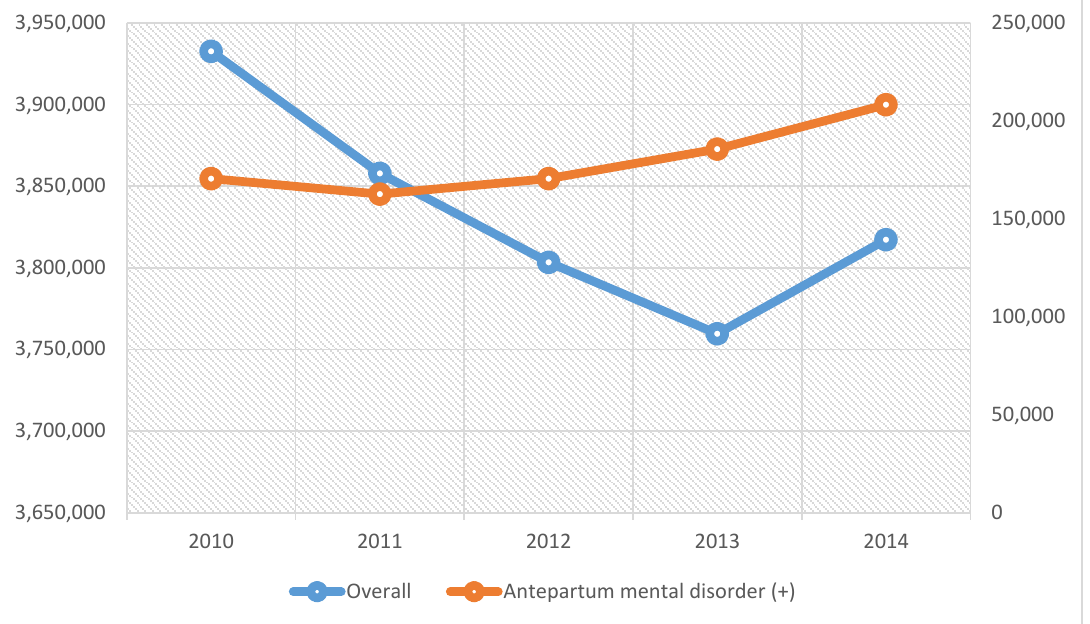
Figure 1. Trends of hospitalizations for pregnancy or birth-related complications and antepartum mental disorders, 2010 to 2014.